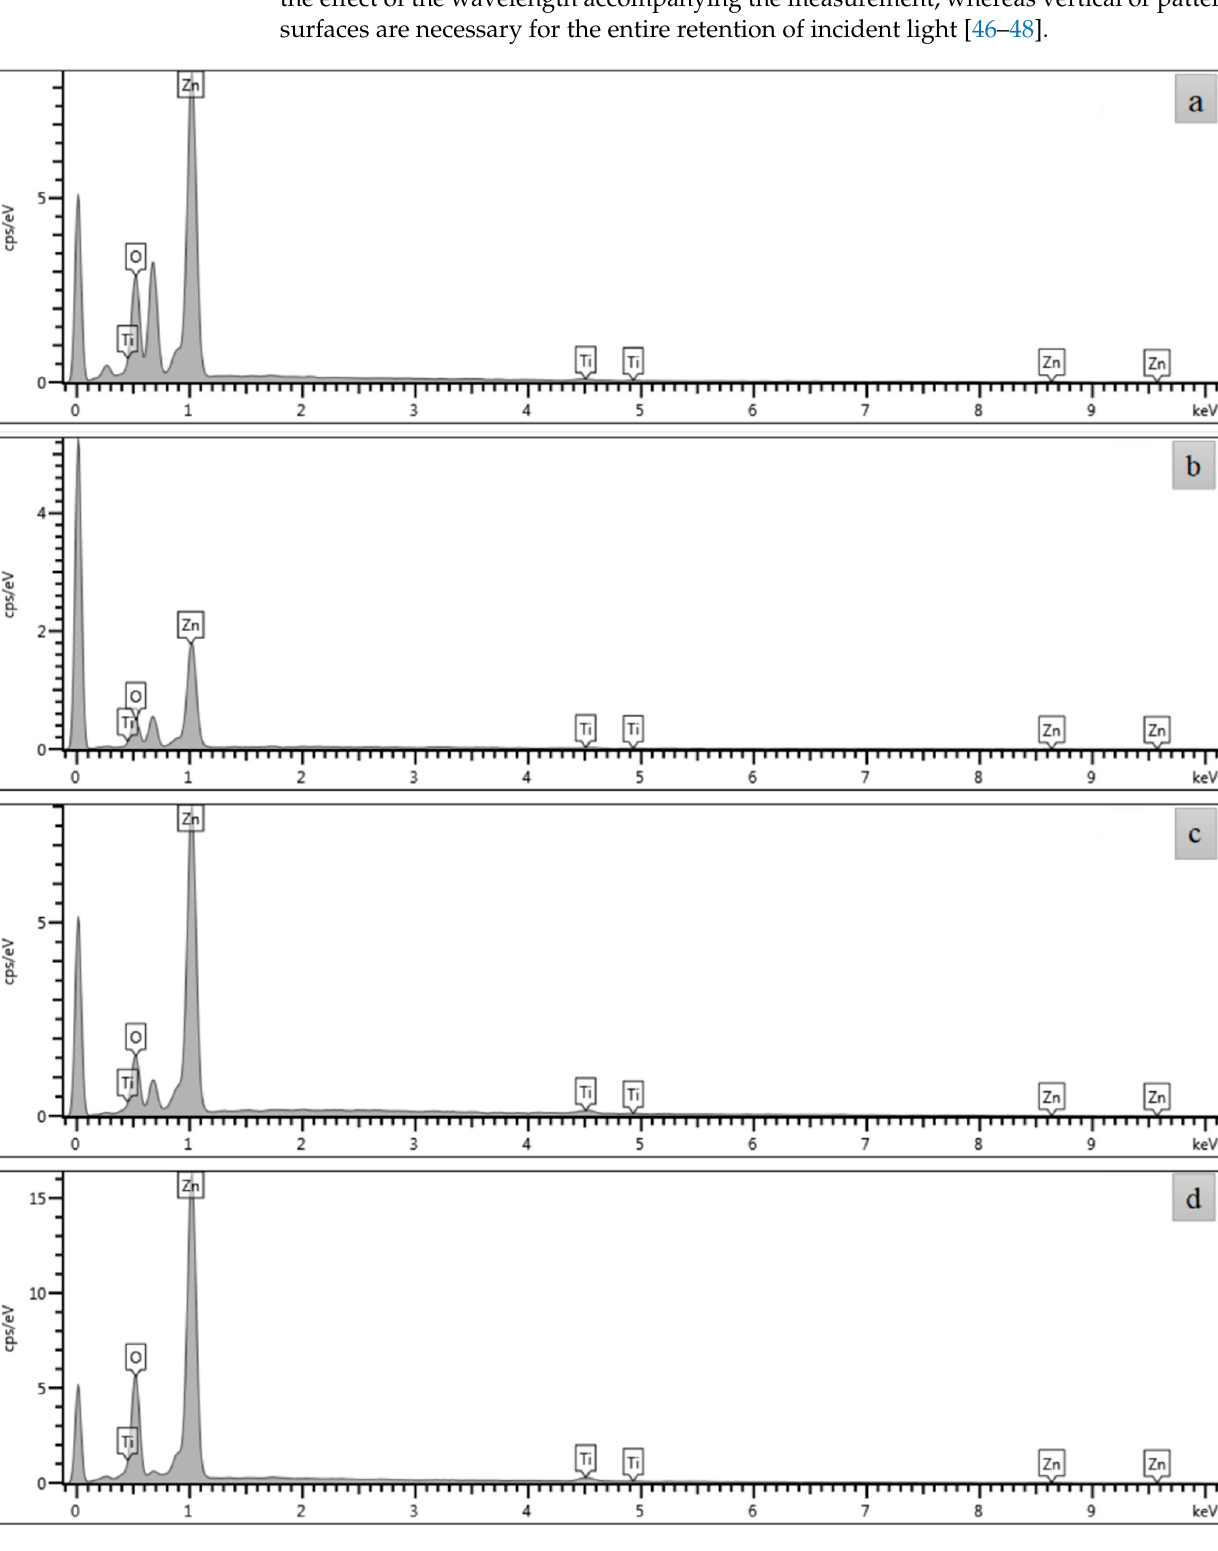
Figure 3. EDX spectrums for the synthesis of nanocomposites on PTFE substrates: ( a ) S 1 , ( b ) S 2 , ( c ) S 3 , and ( d ) S 4 .